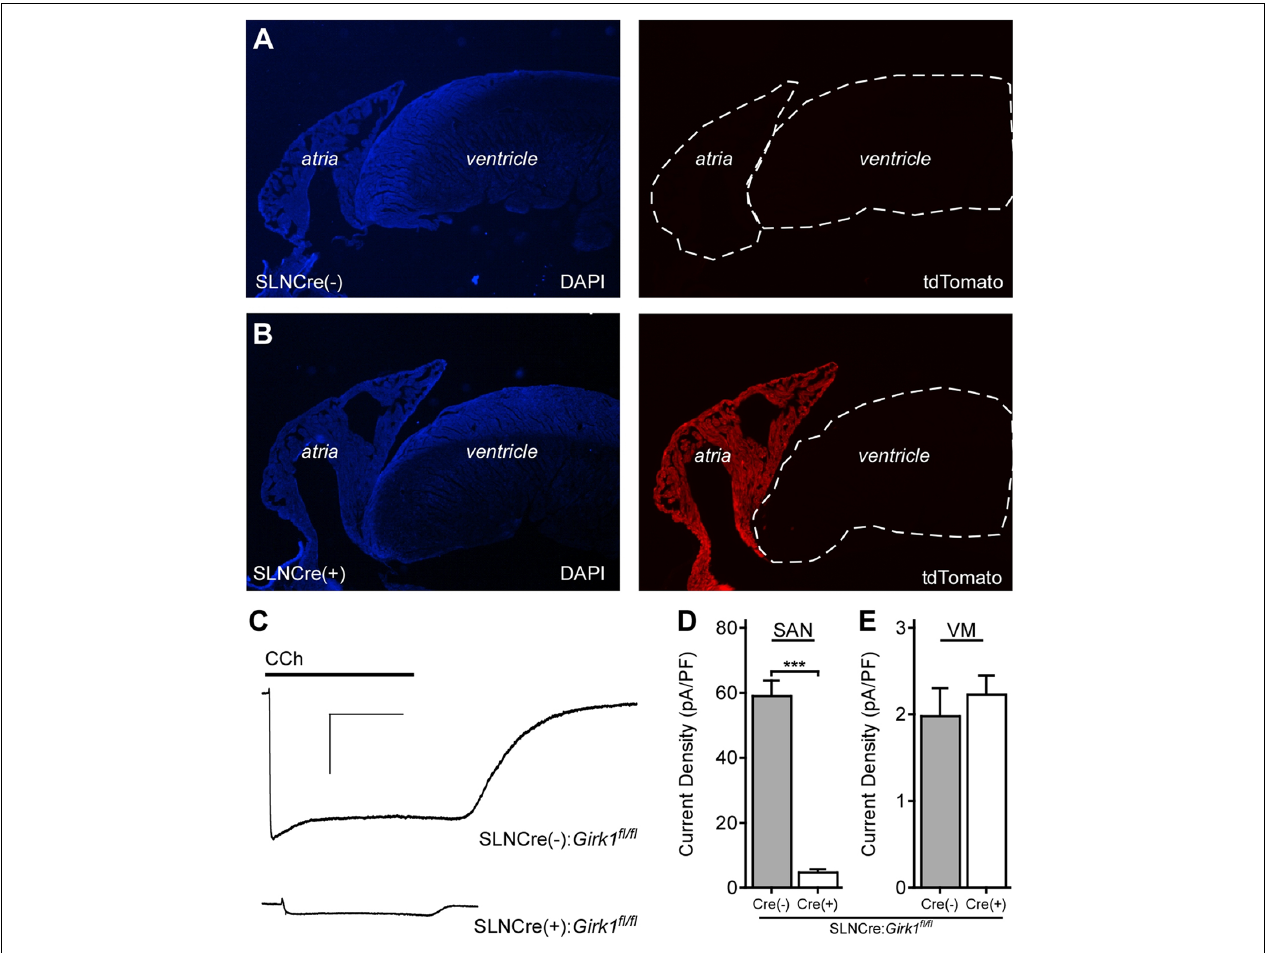
FIGURE 1 | Characterization of an atrial-specific Girk − / − mouse line. (A,B) SLNCre(–) and SLNCre(+) mice were crossed with the Cre - dependent fluorescent reporter strain, Ai14-tdTomato. Representative sections stained with DAPI (Left), and associated tdTomato fluorescence (Right), in hearts from SLNCre(–) (Top) and SLNCre(+) (Bottom) offspring. (C) Representative whole-cell currents ( V hold = –70 mV) evoked by carbachol (CCh, 10 µ M) in a high-K + bath solution in adult SAN cells from SLNCre(–): Girk1 fl / fl and SLNCre(+): Girk1 fl / fl mice. Scale bars: 1 nA/10 s. (D,E) Summary of CCh-induced currents in adult SAN cells ( t 47 = 11.3; / fl and SLNCre(+): Girk1 fl / fl ∗∗∗ P < 0.001; n = 24–25/genotype) and ventricular myocytes (VM; t 21 = 0.6; P = 0.54; n = 11–12/genotype) from SLNCre(–): Girk1 fl